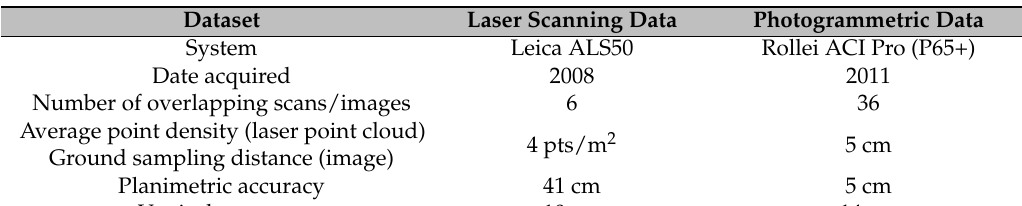
Table 2. A summary of the laser scanning point cloud and imagery characteristics utilized in the second experimental dataset.